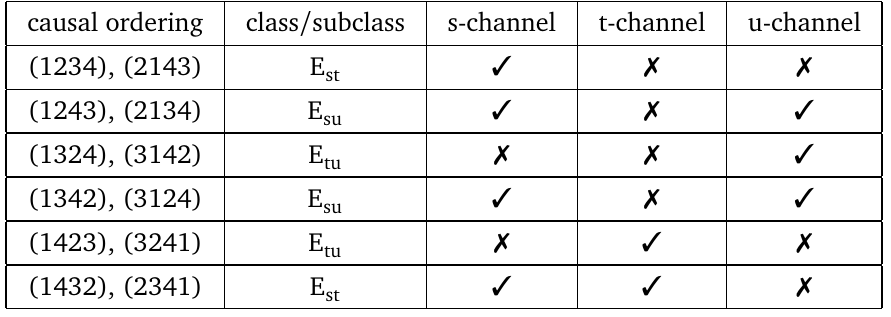
Table 15: OPE convergence properties of type 11 causal